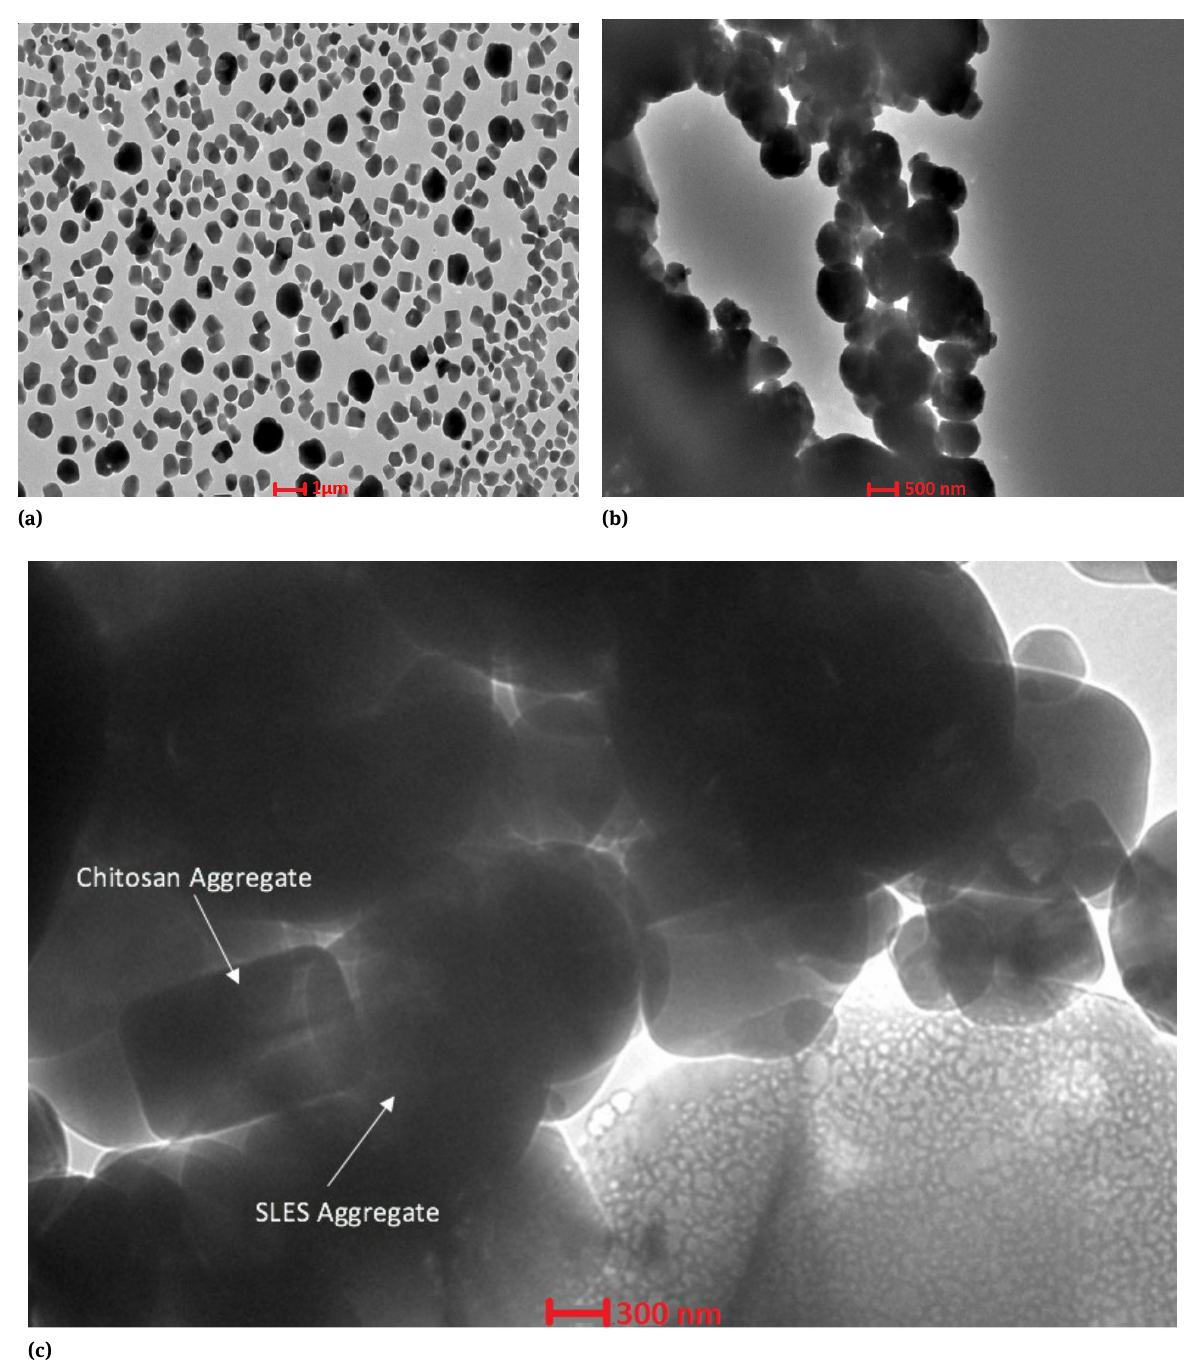
Figure 4: Cryo-TEM images of (a) 300 ppm chitosan, (b) 400 ppm SLES, and (c) chitosan–SLES complex